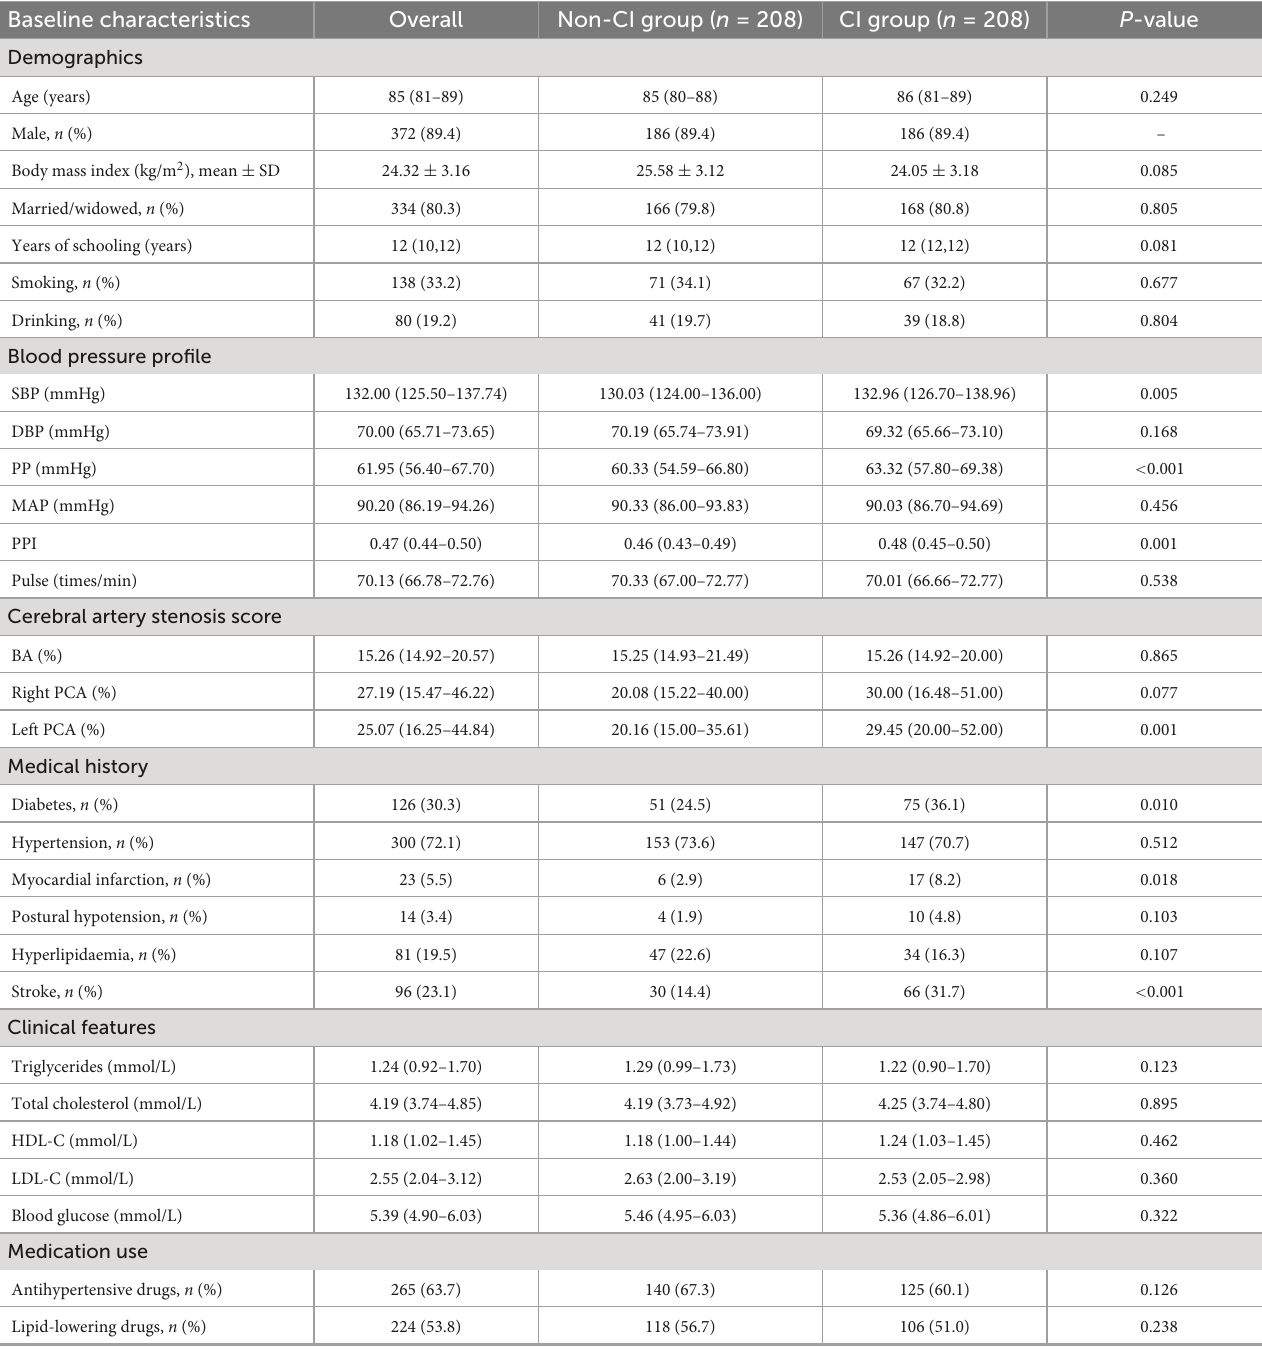
TABLE 1 Baseline characteristics of patients enrolled in this